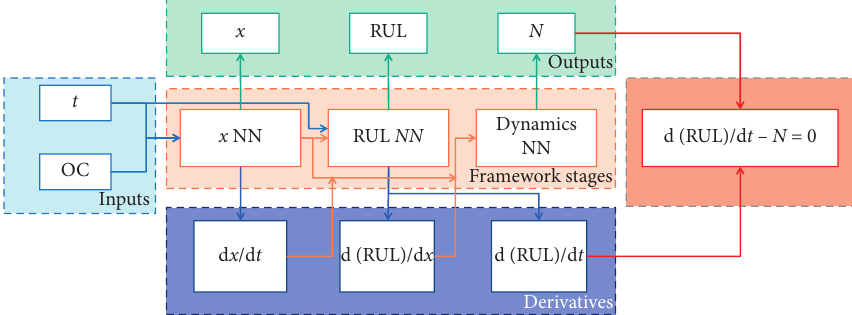
Figure 1: Proposed deep learning framework using a latent variable and a PDE-like penalization